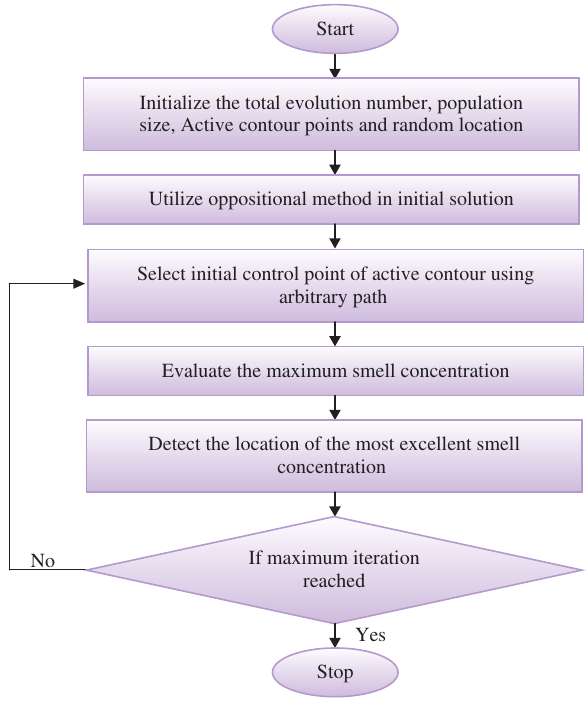
Figure 2: Flow Diagram of the Proposed